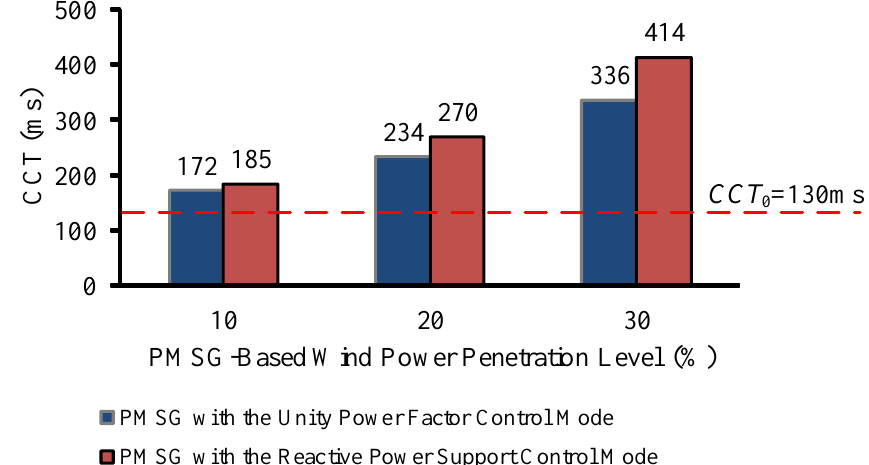
Figure 13. CCTs of the fault on line 7–8 in the scenarios of PMSG-based wind power balanced by G2.